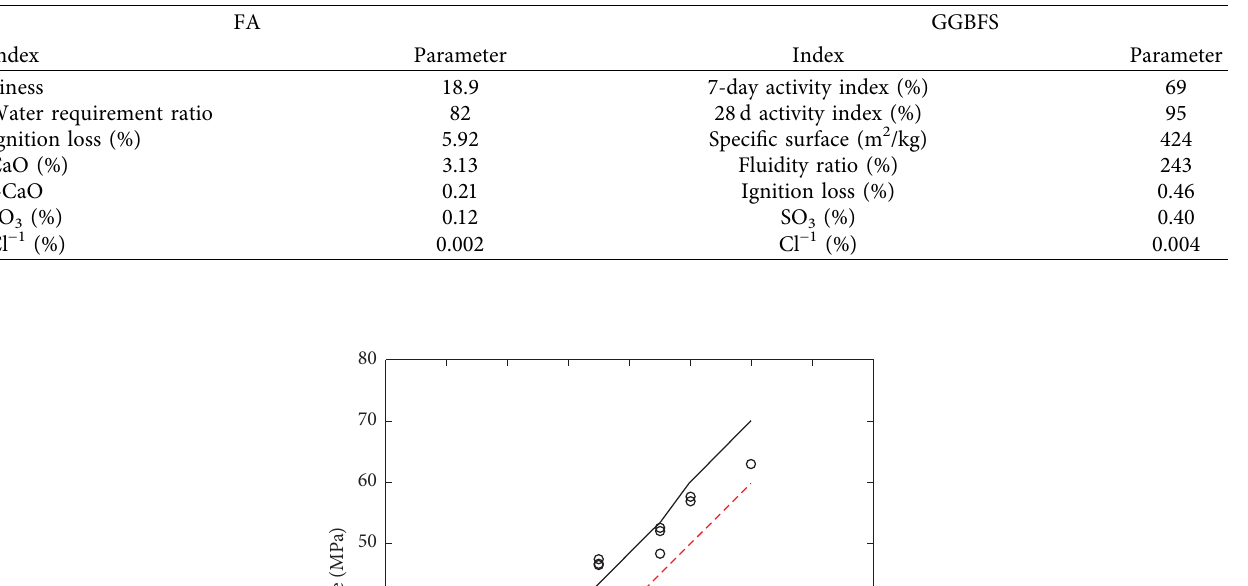
Table 12: Physical properties and chemical compositions of FA and GGBFS.